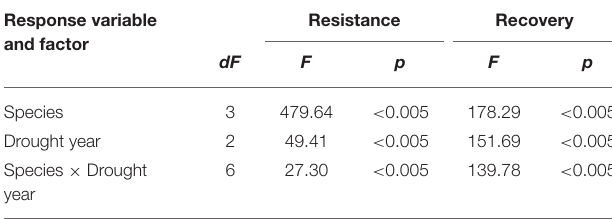
TABLE 2 | ANOVA for comparison of drought response among tree species and drought years. Response variable and